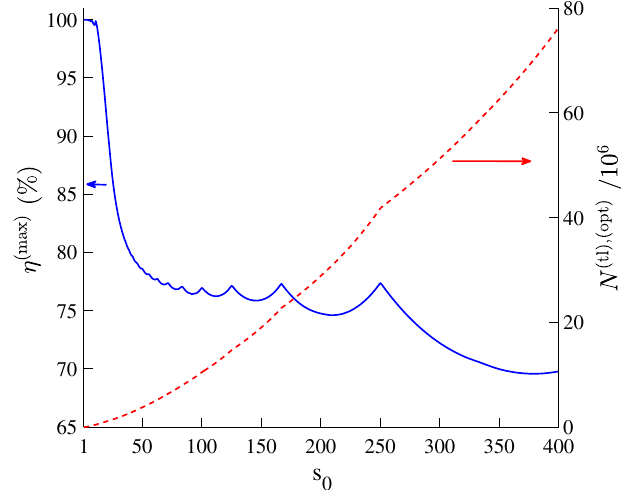
FIG. 11. The maximum efficiency (blue solid curve) and the corresponding optimum electrons per microbunch, N ð tl Þ ; ð opt Þ , (red dashed curve) as function of the resonance mode s 0 ; the number of microbunches is 2000.